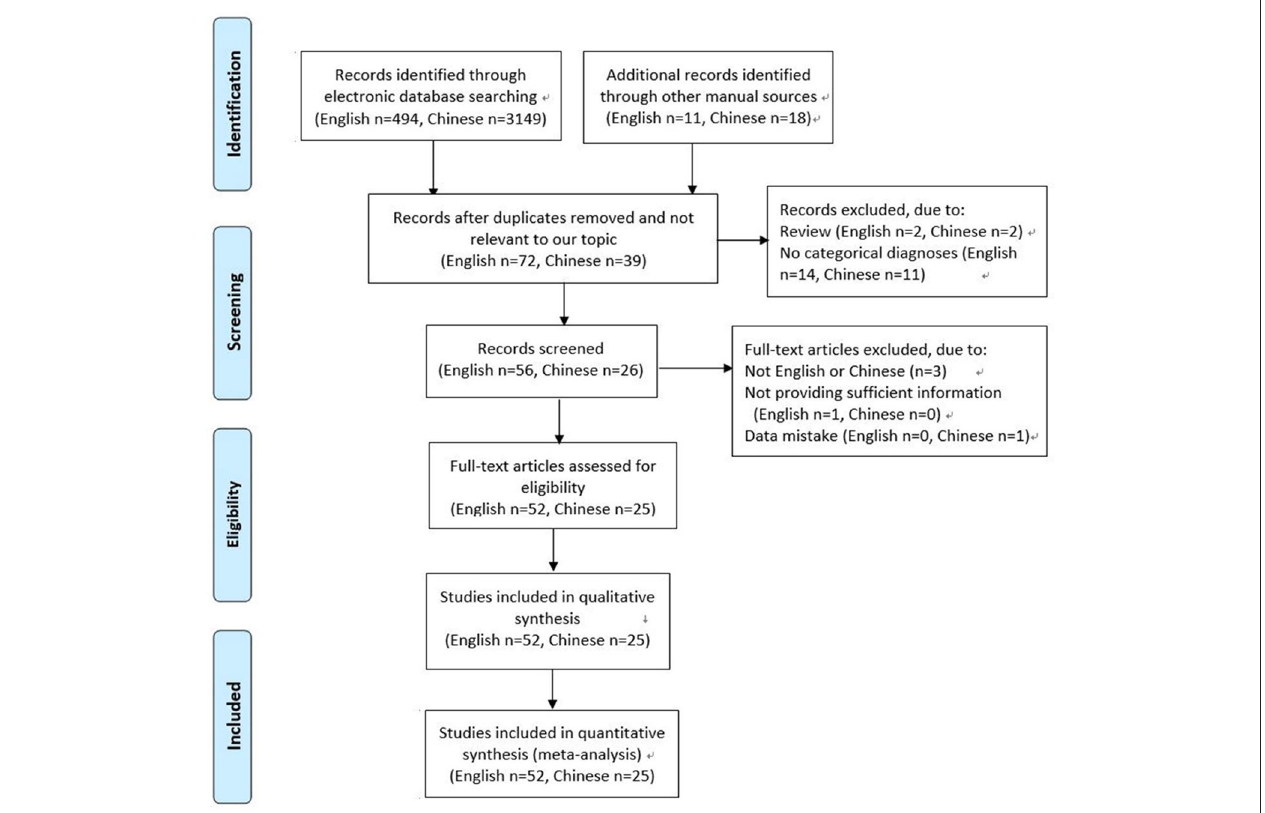
FIGURE 1 | Flow diagram of the study selection